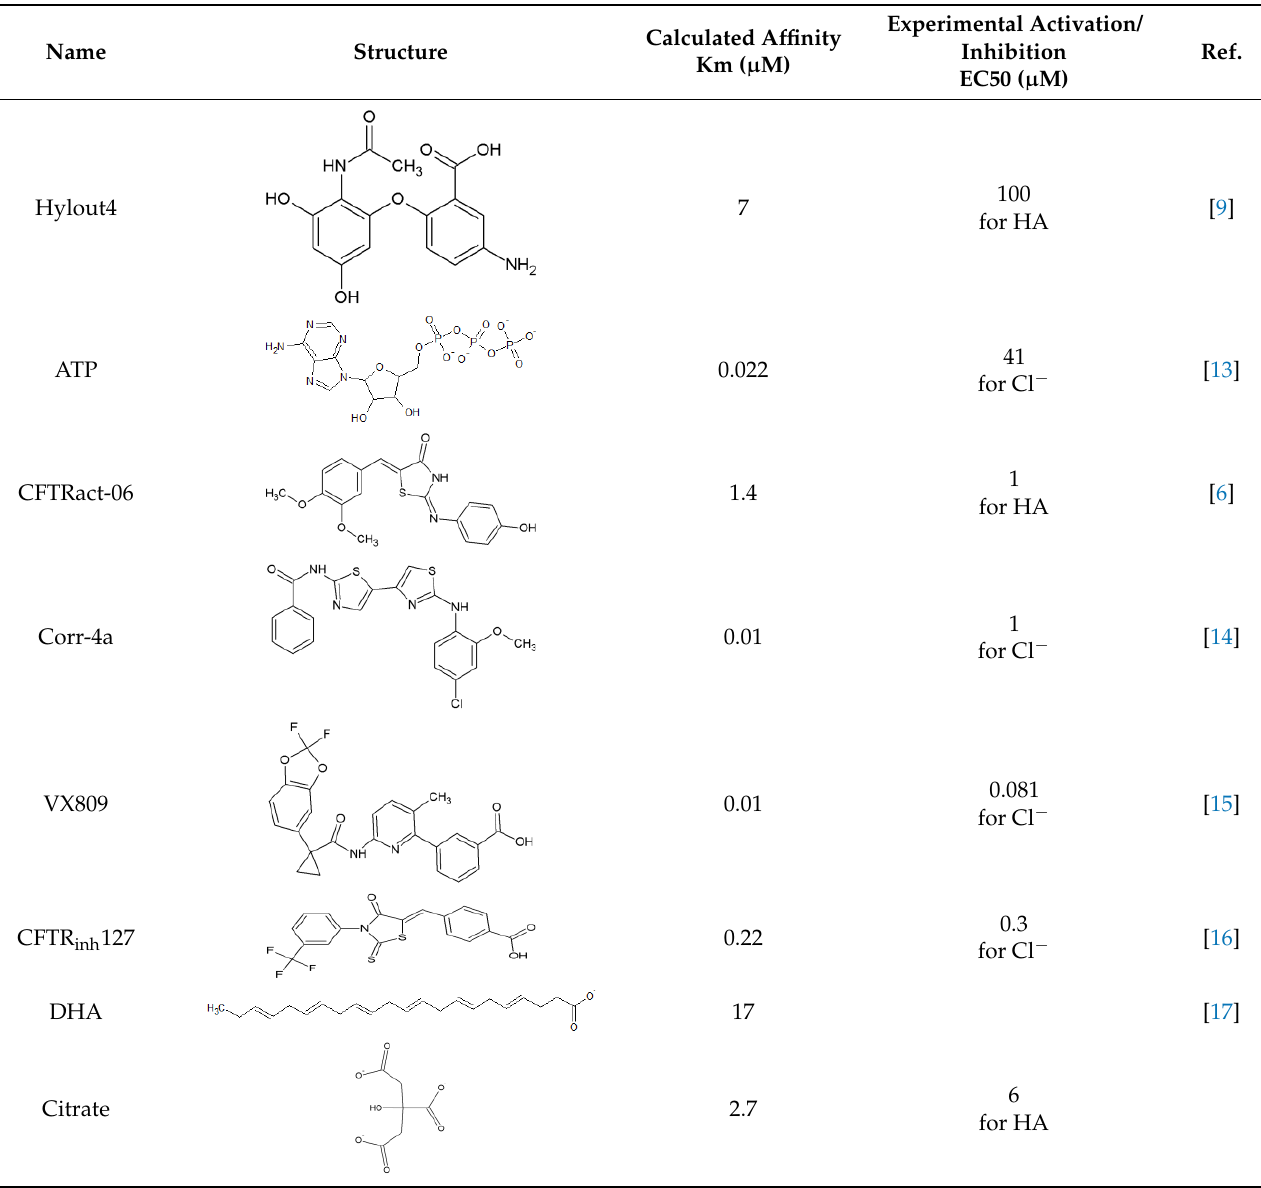
Table 1. Virtual docking of activators and inhibitors to the open conformation of CFTR.